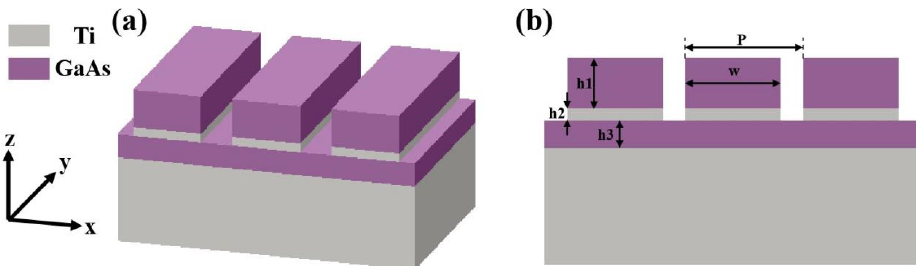
Figure 1. ( a ) Three-dimensional structure of our absorber. ( b ) The cross-sectional view of the ab-